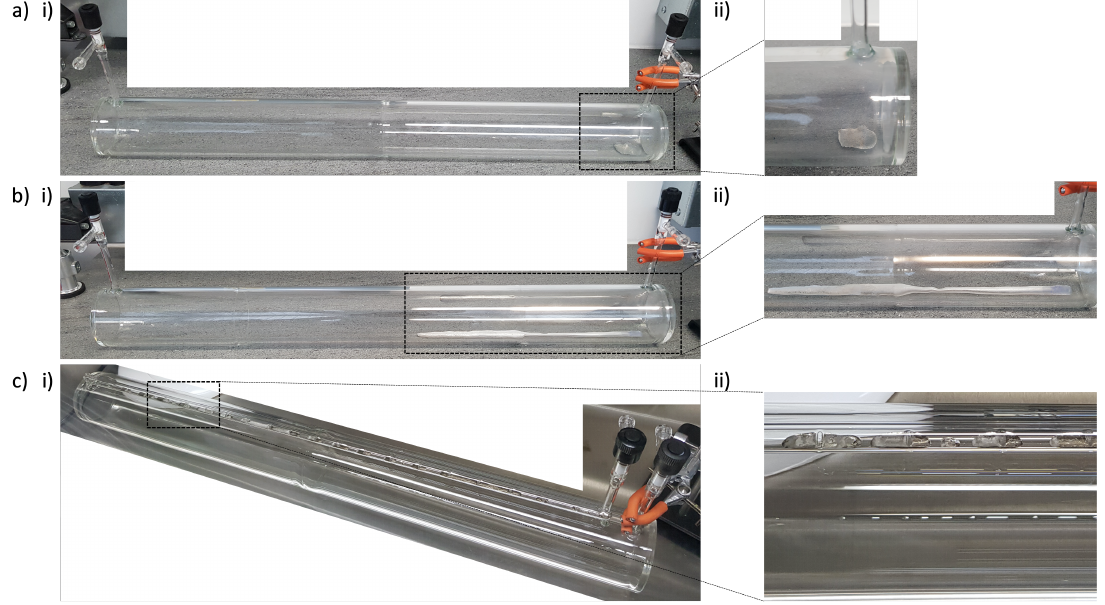
Figure 1. SEOP cells with different Rb source distributions; ( a ) 1 g of Rb placed at the back of the cell, with an estimated surface area ∼ 10 cm 2 ; ( b ) 5 g of Rb placed in the cell, with an estimated surface area ∼ 64 cm 2 ; ( c ) 2g of Rb distributed along the presaturator, ( i ) showing the geometry of the cell and ( ii ) showing a close-up of the Rb